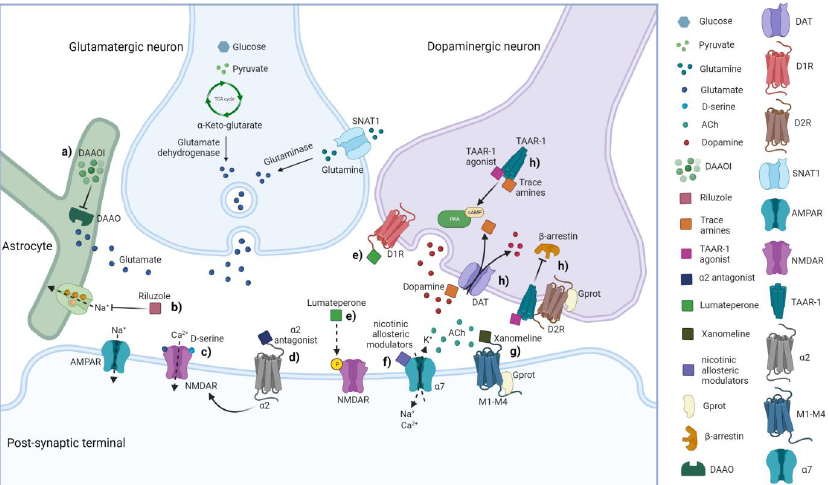
Figure 3. Mechanisms of action of molecules with non-canonical antipsychotic action: ( a ) DAAO inhibitors are capable of inhibiting the DAAO enzyme expressed by astrocytes; ( b ) riluzole reduces the synaptic release of glutamate by inhibiting voltage-gated sodium channels and calcium currents and increases astrocytic reuptake of glutamate enhancing cortical glutamate metabolism [145,146]; ( c ) D-serine acts as a co-agonist at synaptic NMDARs enhancing glutamatergic tone and its levels are reduced by DAAO activity, responsible for D-serine catabolism; ( d ) α2 antagonist enhances both cortical dopamine release and NMDAR-mediated responses; ( e ) lumateperone acts on dopaminergic D1R and D2R stimulating the phosphorylation of NMDAR subunits [147]; ( f ) α7 nicotinic positive allosteric modulators mitigate cognitive symptoms by eliciting acetylcholine release; ( g ) xanomeline is a central selective muscarinic agonist of M1 and M4 demonstrated to have antipsychotic properties despite being devoid of a direct effect on D2R [148]; ( h ) TAAR-1 agonists act on the in- tracellular TAAR1 receptors expressed by dopaminergic neurons and functionally related to recep- tors for biogenic amines. DAAO, D-amino acid oxidase; DAAOI, D-amino acid oxidase inhibitor; SNAT1, Sodium coupled neutral amino acid transporter 1; AMPAR, α-amino-3-hydroxy-5-methyl- 4-isoxazolepropionic acid receptor; NMDAR, N-methyl-D-aspartate receptor; D1R, Dopamine re- ceptor D1; D2R, Dopamine receptor D2; cAMP, Cyclic adenosine monophosphate; PKA, Protein kinase A; TAAR-1, Trace amine-associated receptors 1; DAT, Dopamine transporter; P, phosphory- lation; Ach, Acetylcholine; M1, Muscarinic receptor 1; M4, Muscarinic receptor 4; α2, α2 adrenocep- tor; α7, α7 nicotinic receptor; Gprot, G protein; Na + , Sodium; Ca 2+ , Calcium; K + , Potassium. Created with BioRender.com on 7 March 2023.